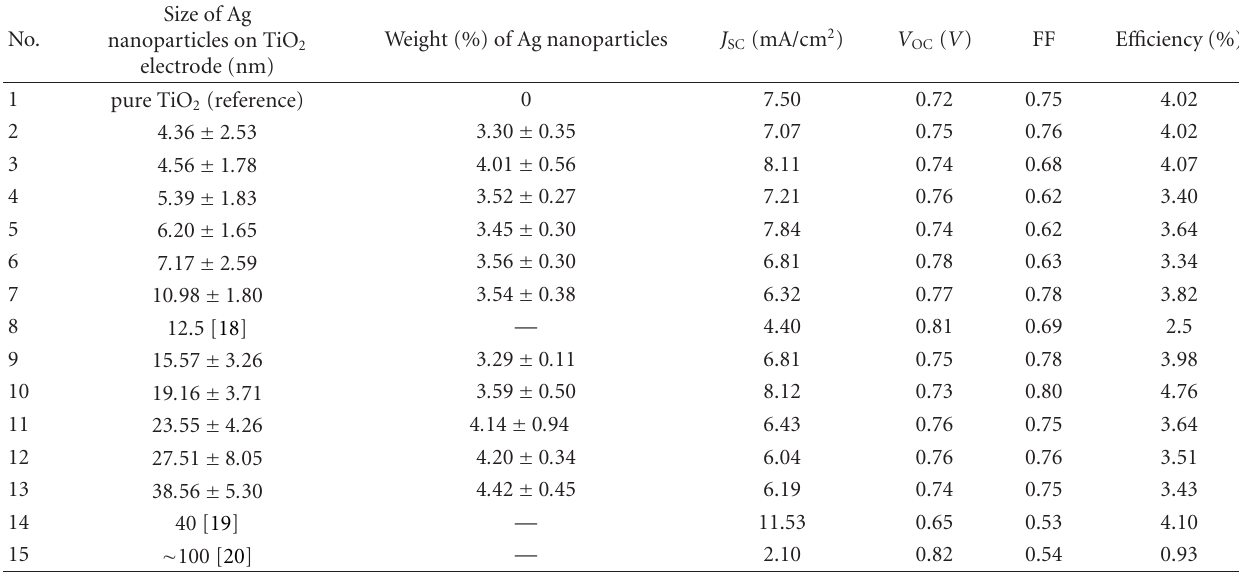
Figure 9: Variation of (a) open-circuit voltage ( V OC ) and short-circuit current density ( J SC ), (b) fill factor (FF) and energy conversion e ffi ciency of DSC with TiO 2 /Ag (19.16 nm) electrode during a short-term stability test. Table 1: Weight (%) of Ag nanoparticles obtained from SEM-EDX analysis, short circuit current densities ( J SC ), open circuit voltages ( V OC ), fill factors (FF), and e ffi ciencies of DSCs prepared using the TiO 2 /Ag composite film electrodes compared with pure TiO 2 electrode (reference) under